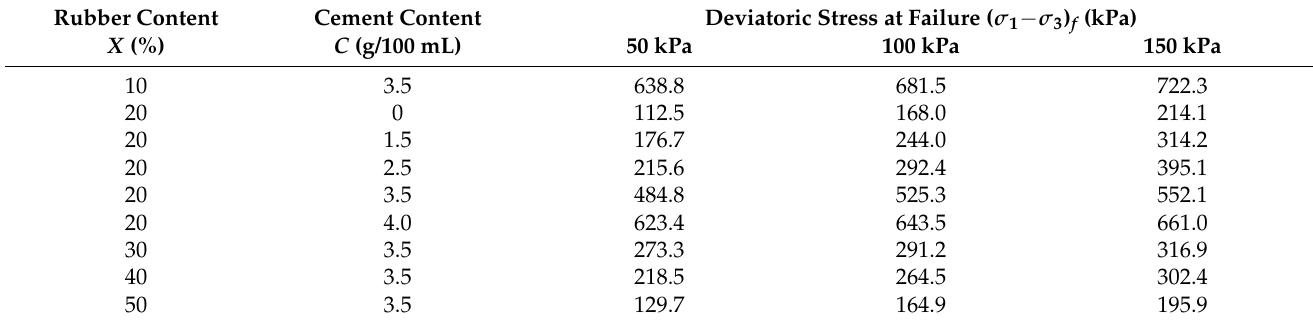
Table 3. Deviatoric stress at failure under different working conditions.